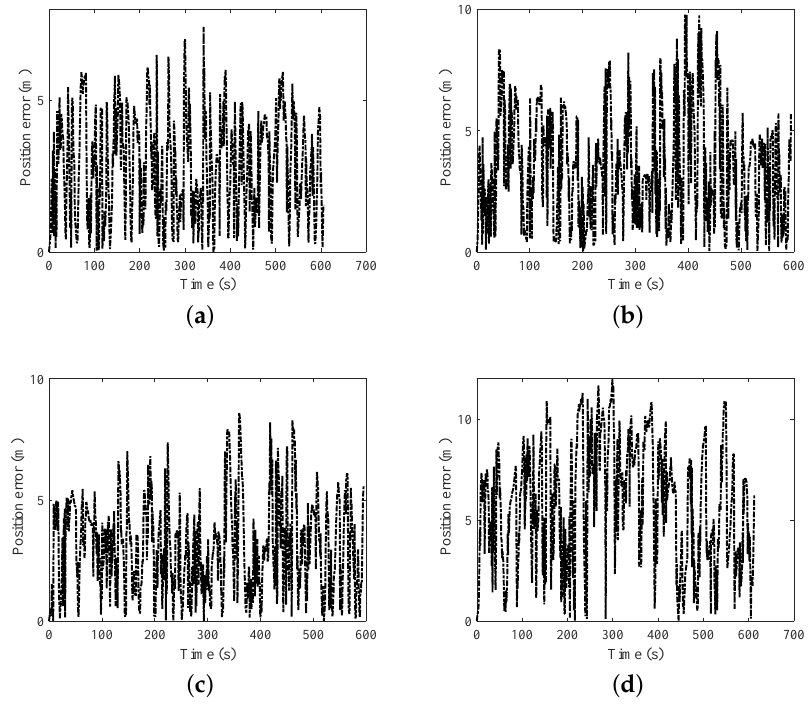
Figure 12. Position errors with different gestures in office building: ( a ) calling; ( b ) dangling; ( c ) handheld; and ( d )